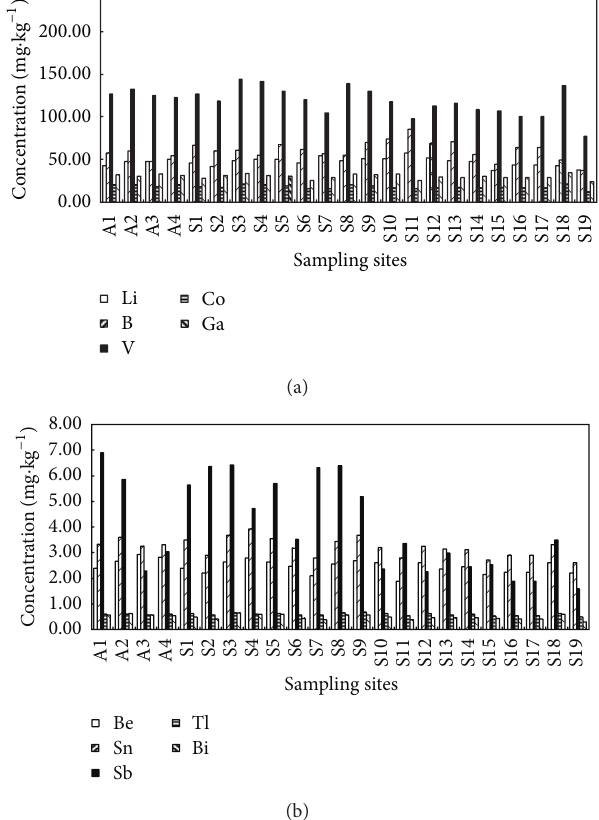
Figure 2: Spatial distribution of SMTEs in sediments from TGR